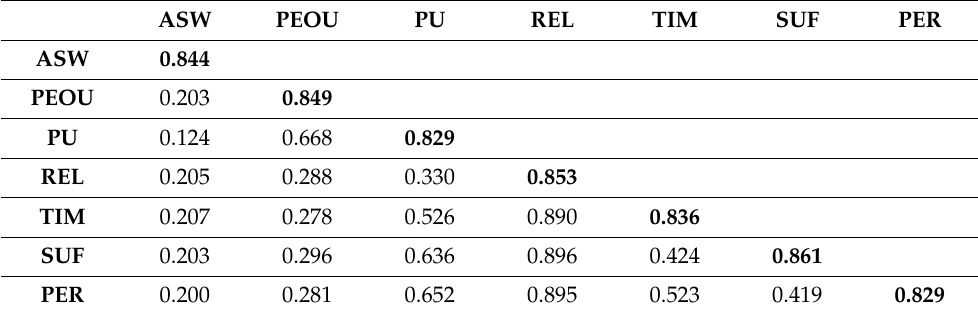
Table 6. Fornell-Larcker Scale.